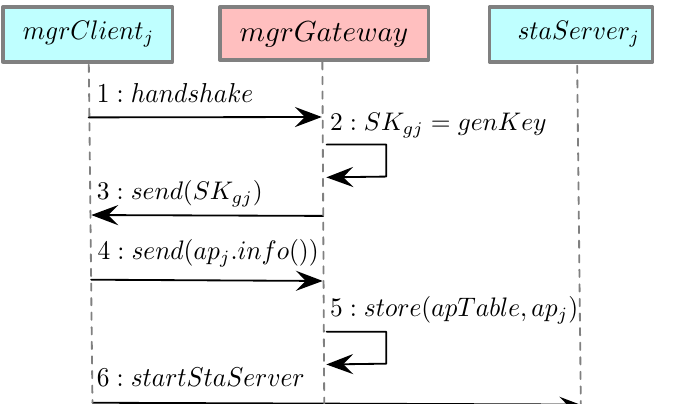
Figure 2. Sequence diagram describing the process of adding a new AP to the network. Once added, the new AP can be used for computational